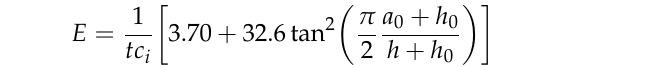
Figure 13. The red chain-dotted lines are used to identify the first and the second turning points of AE signals, named as M and N ,